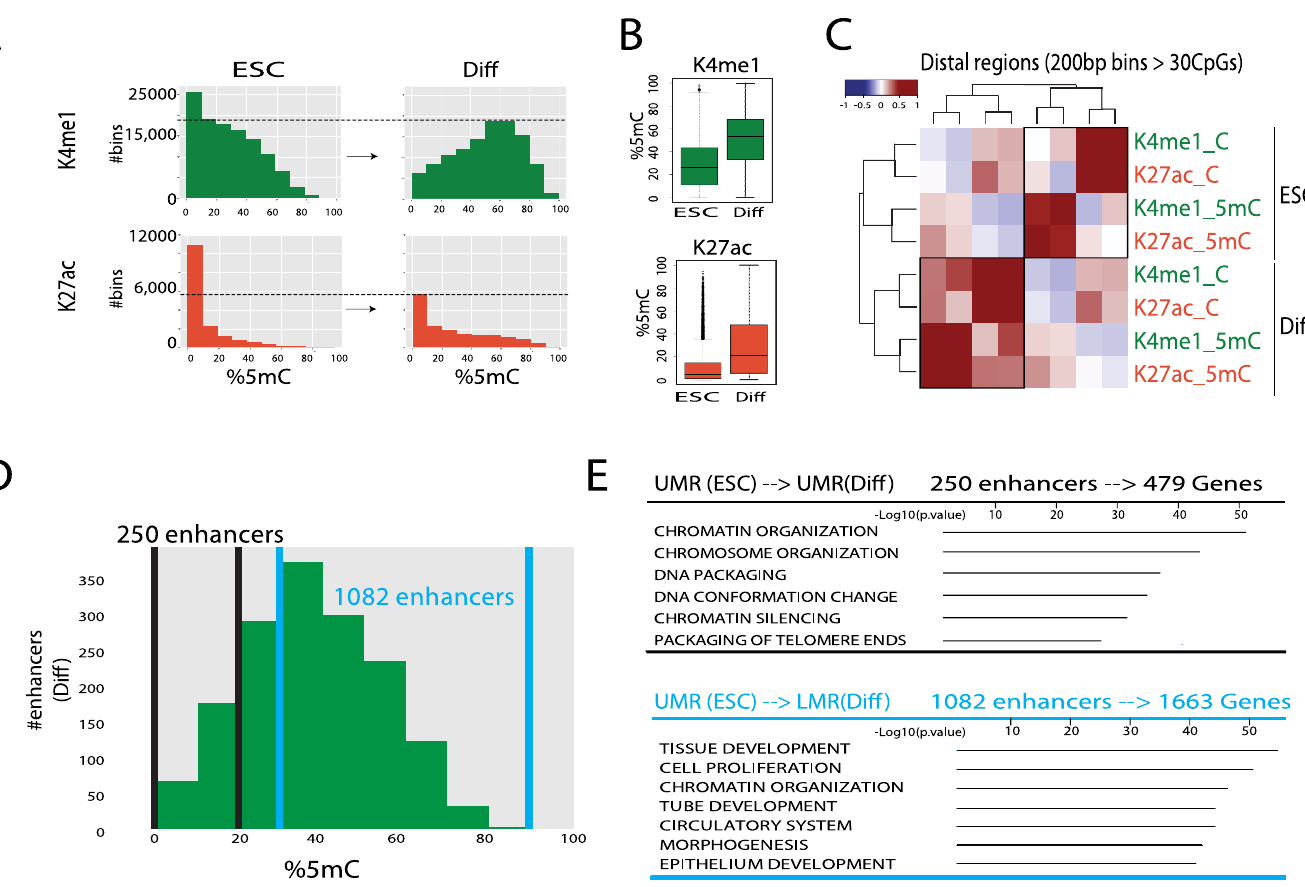
Fig 2. Enhancer-specific DNA methylation occurs during differentiation. (A) Histograms of number of bins with indicated 5mC percentages for H3K4me1 and H3K27ac in ESCs and differentiated cells (Diff) over distal enhancers; percentages were calculated in 200-bp genomic segments. (B) Boxplots of 5mC percentages in H3K4me1-bound regions (n = 111,377) and H3K27ac-bound regions (n = 16,019) in ESCs and differentiated cells. Thick lines indicate the medians. The boxes range from 25%-75%, and the whiskers extend to ± 1.5 of the interquartile range. (C) Spearman rank correlations between H3K4me1 and H3K27ac ChIP-seq maps of distal enhancers for ESCs and differentiated cells, separating signals of C vs. 5mC levels (#reads) within 200-bp genomic bins. (D) Histogram of 5mC% in regions bound by H3K4me1 in differentiated cells that were UMRs in ESCs; percentages were calculated in 200-bp bins. (E) MsigDB Gene Ontology terms [67] of genes regulated by enhancers that remained in the UMR state after differentiation (upper table) and of enhancers that were UMRs in ESCs and became LMRs in differentiated cells (lower table). Only top enriched GO categories were shown. Complete gene list can be found in S3